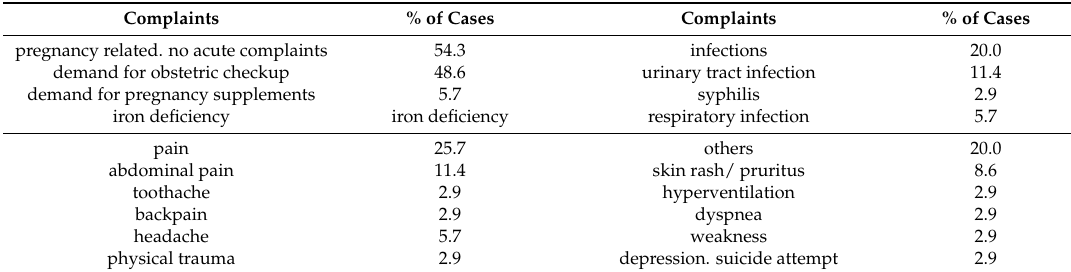
Table 3. Overview on pregnancy associated medical complaints and requests (proportion of all consultations in all three